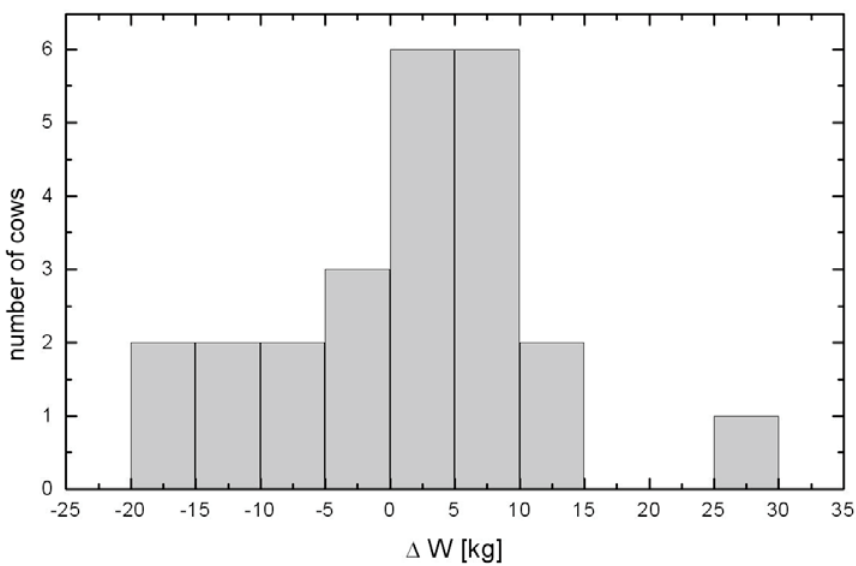
Figure 6 Distribution of differences ΔW=W2−W2 (W2: water level at second sampling, W1: water level at first sampling)